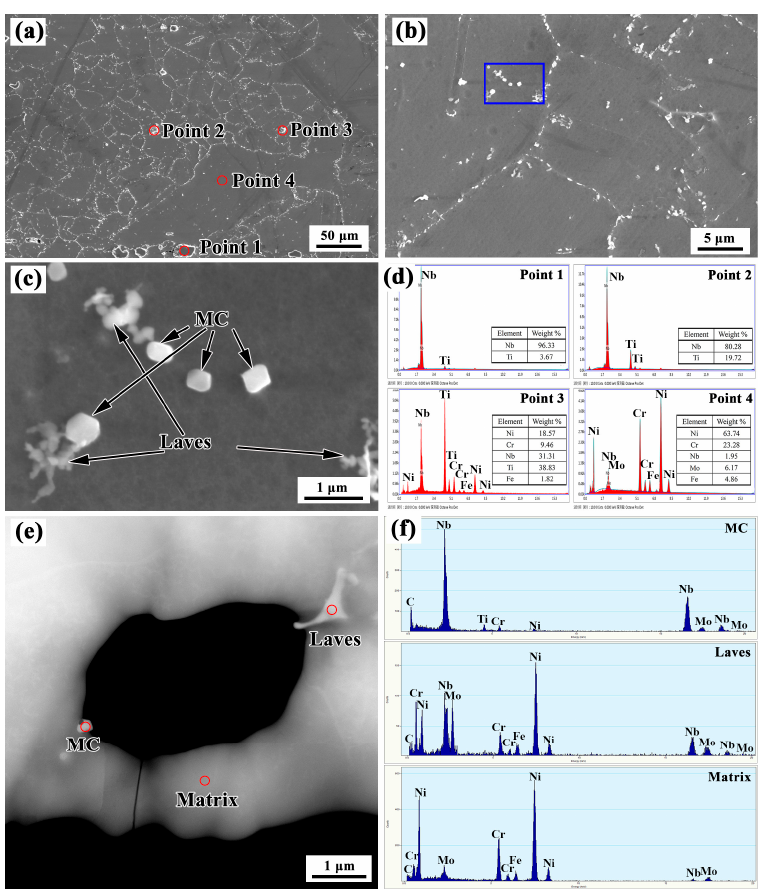
Figure 8. ( a – c ) SEM images, ( e ) transmission electron microscope (TEM) images, and ( d , f ) energy-dispersive X-ray spectrometry (EDS) results in the